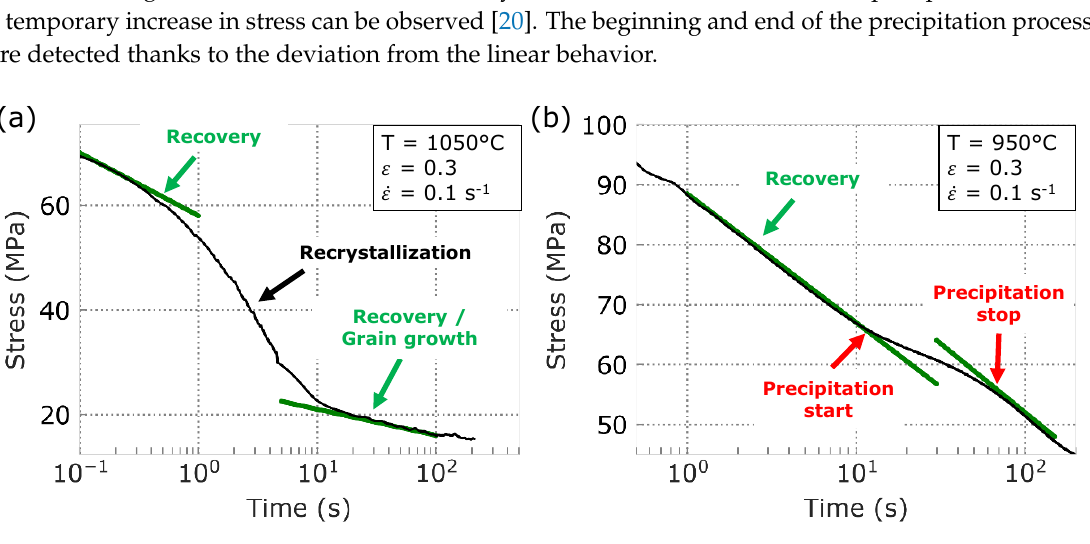
Figure 2. Illustration of the stress relaxation curves obtained at ( a ) 1050 ◦ C and ( b ) 950 ◦ C for (cid:101) = 0.3 and ˙ (cid:101) = 0.1s − 1